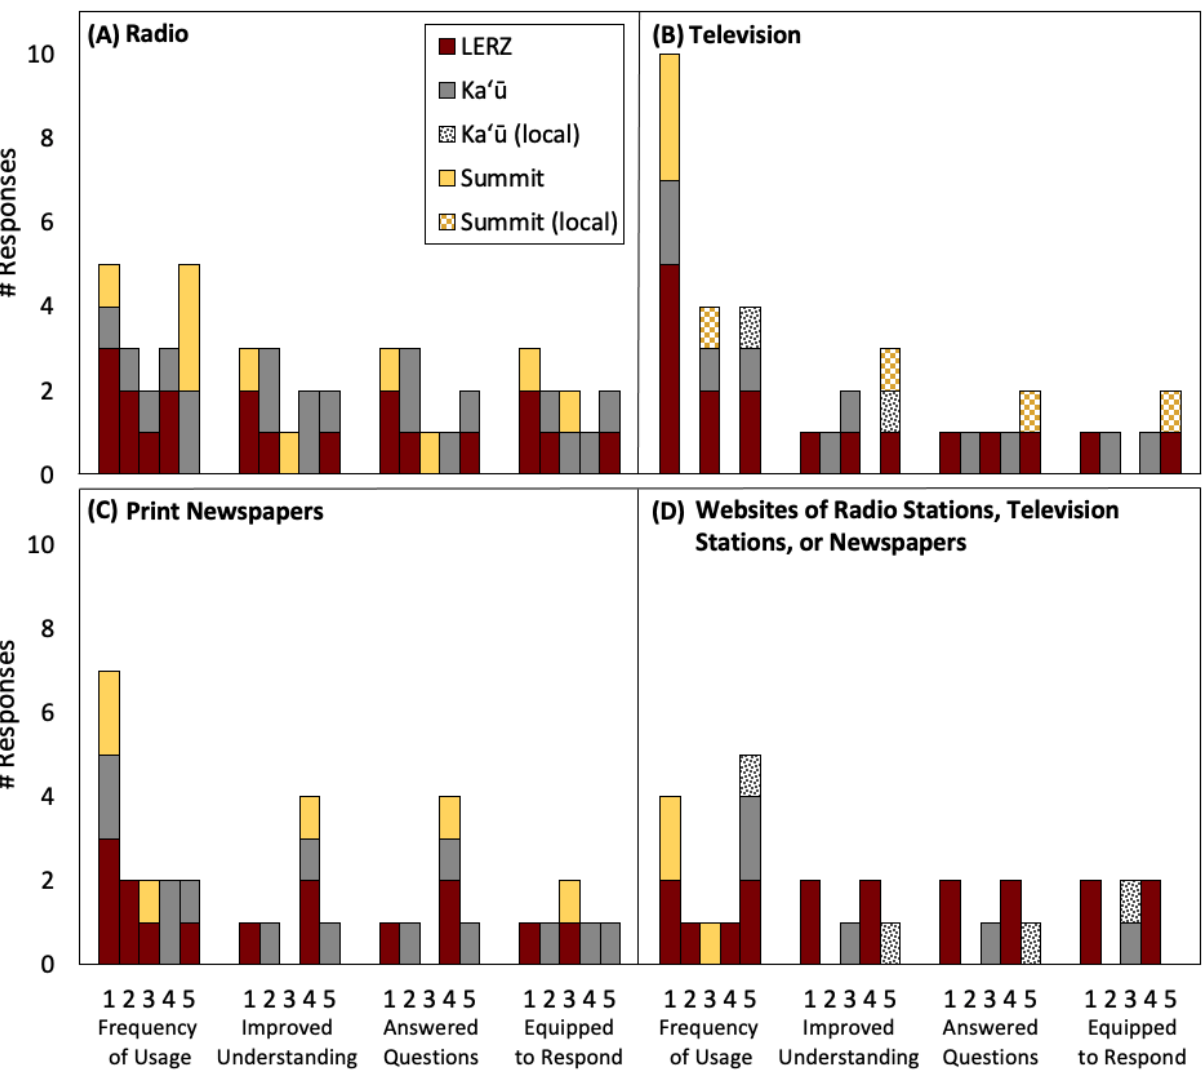
Figure 3: Participants’ responses regarding eruption information communicated through [A] radio broadcasts, [B] television broadcasts, [C] print newspapers, and [D] websites of radio stations, television stations, or newspapers. In each panel, the first cluster of bar graphs tallies participants’ Likert-type score responses for how often they viewed each channel, while the remaining three clusters plot participants’ Likert-type score responses to the following questions: “During the eruption, to what extent did you feel that [each channel] ... (a) improved your understanding of volcano hazards?; (b) answered your questions about the eruption and [summit caldera] collapse?; and (c) helped you feel better equipped to respond to the eruption?” Our Likert-type scale corresponds with the following qualitative descriptions: 1: "not at all," 2: “not much,” 3: “fair,” 4: “great,” 5: "very great." Follow-up questions were not asked of people who reported viewing a channel “not much” or “not at all.” Gray- speckled and yellow-checkered bars are responses from Ka ‘ ¯u and summit participants, respectively, pertaining to the local news